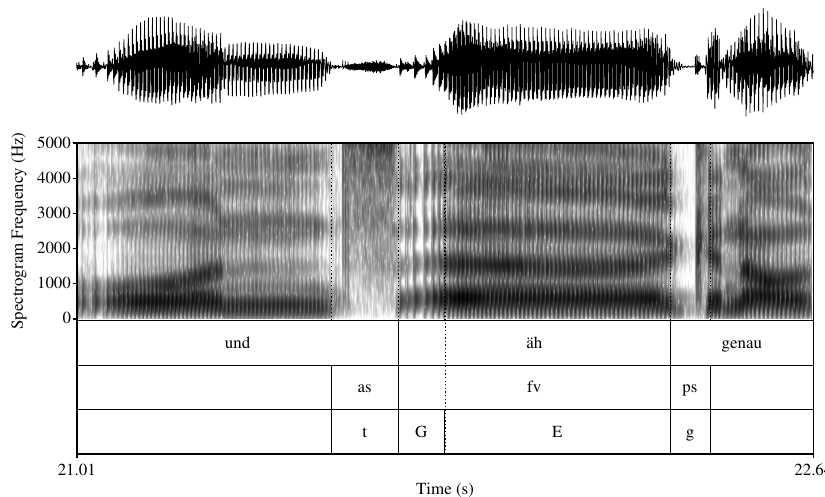
Figure 6. Example of a filler particle äh (602 ms) in und äh genau ‘and uh right’, with a left segmental context (as) before the vocalic filler particle (fv), followed by a right segmental context (ps). G denotes a glottalized sequence, E the vowel (source: n_frei_m15).